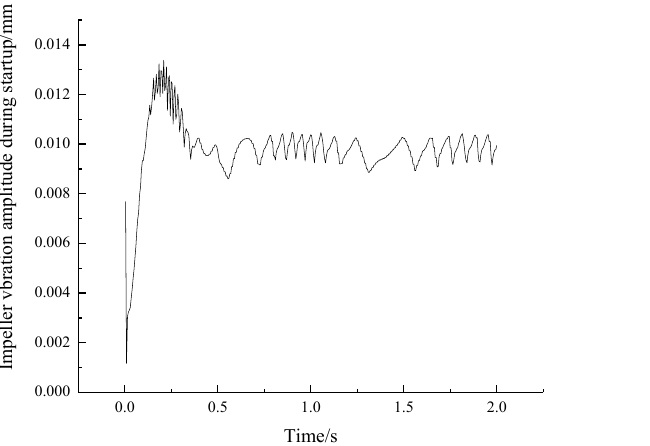
Figure 8. The vibration amplitude curve of the centrifugal pump impeller during the startup process.